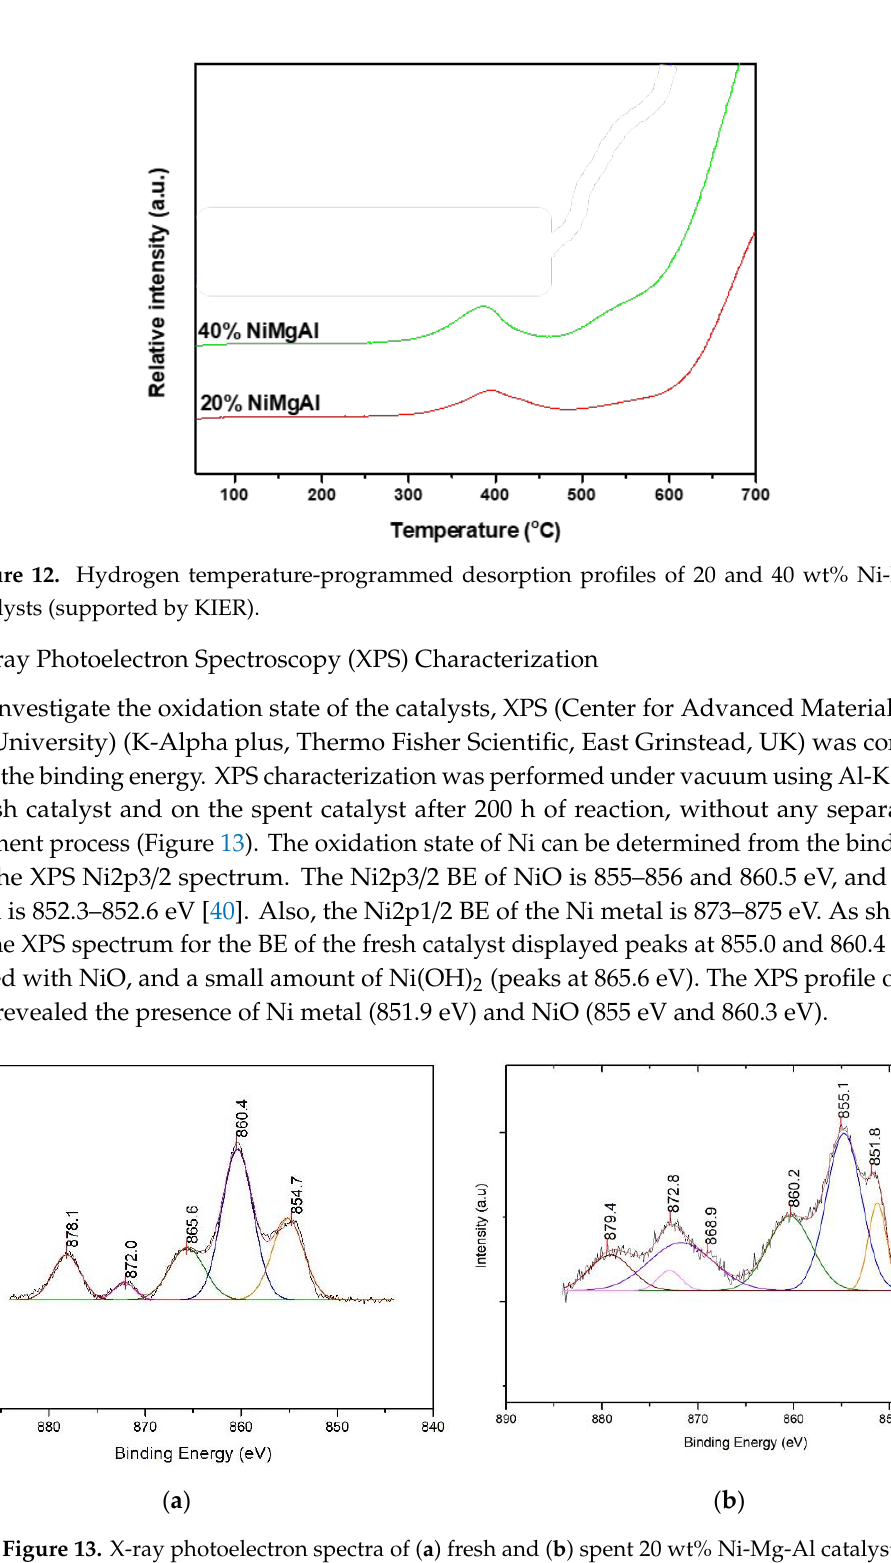
Figure 13. X-ray photoelectron spectra of ( a ) fresh and ( b ) spent 20 wt% Ni-Mg-Al catalysts.